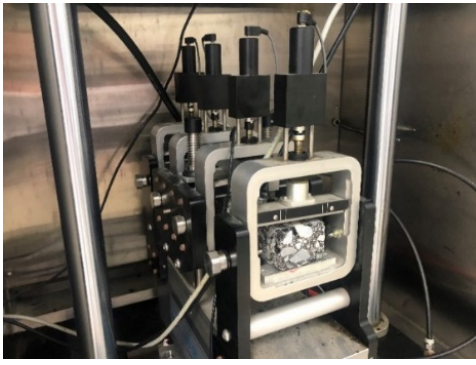
Figure 4. Four-point bending beam fatigue test.